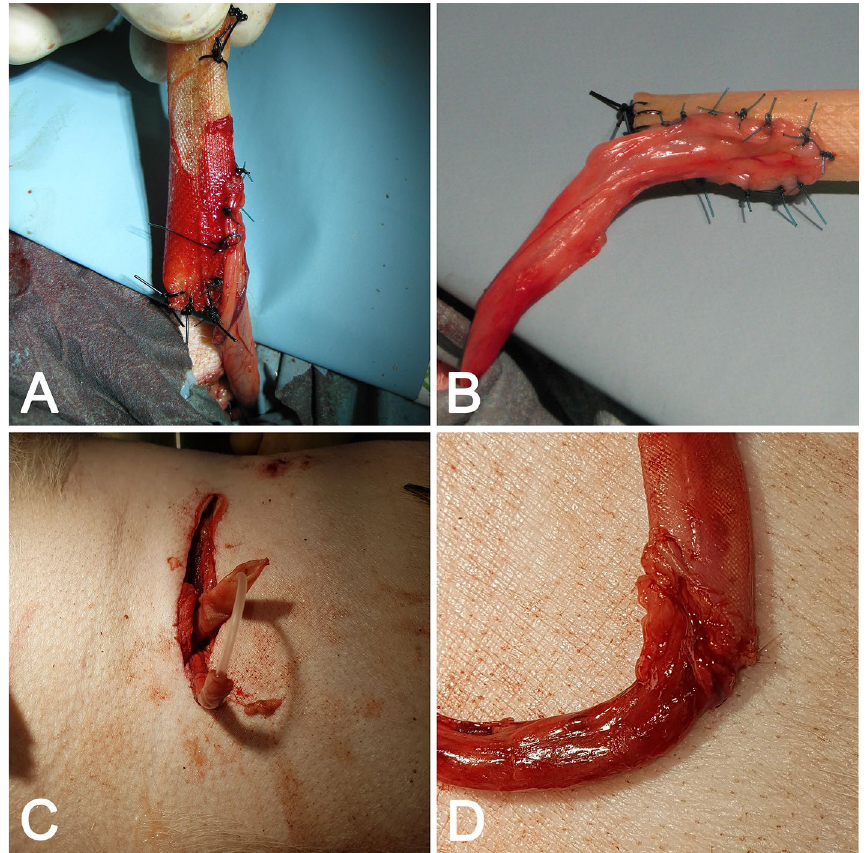
Figure 3. Method of side-by-side uretero-conduit anastomosis. ( A , B ) The anastomosis between AC and ureter from different point of view-Group 2, ( C , D ) Group 3—pre-implanted and prepared AC for anastomosis by trimmed tip, ( D ) AC anastomosed with